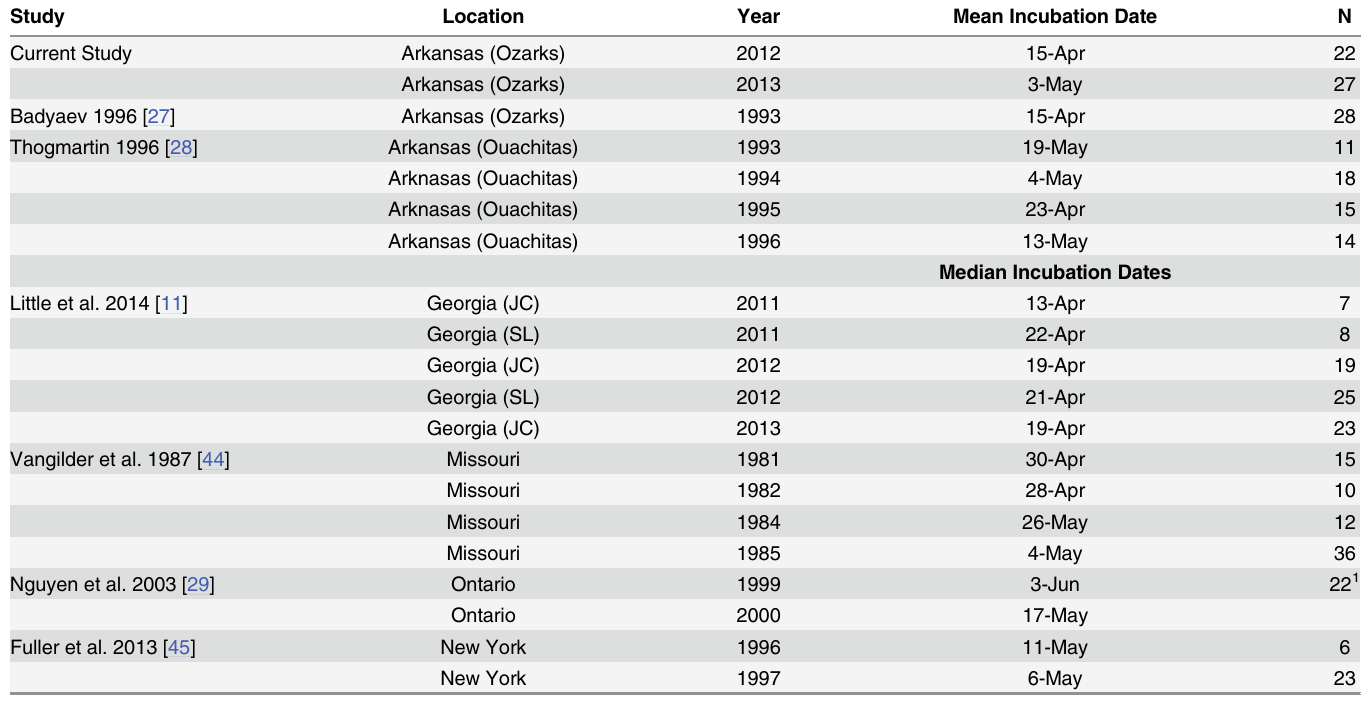
Table 2. Comparison of eastern wild turkey ( Meleagris gallopavo silvestris ) incubation dates from across the sub-species' North American